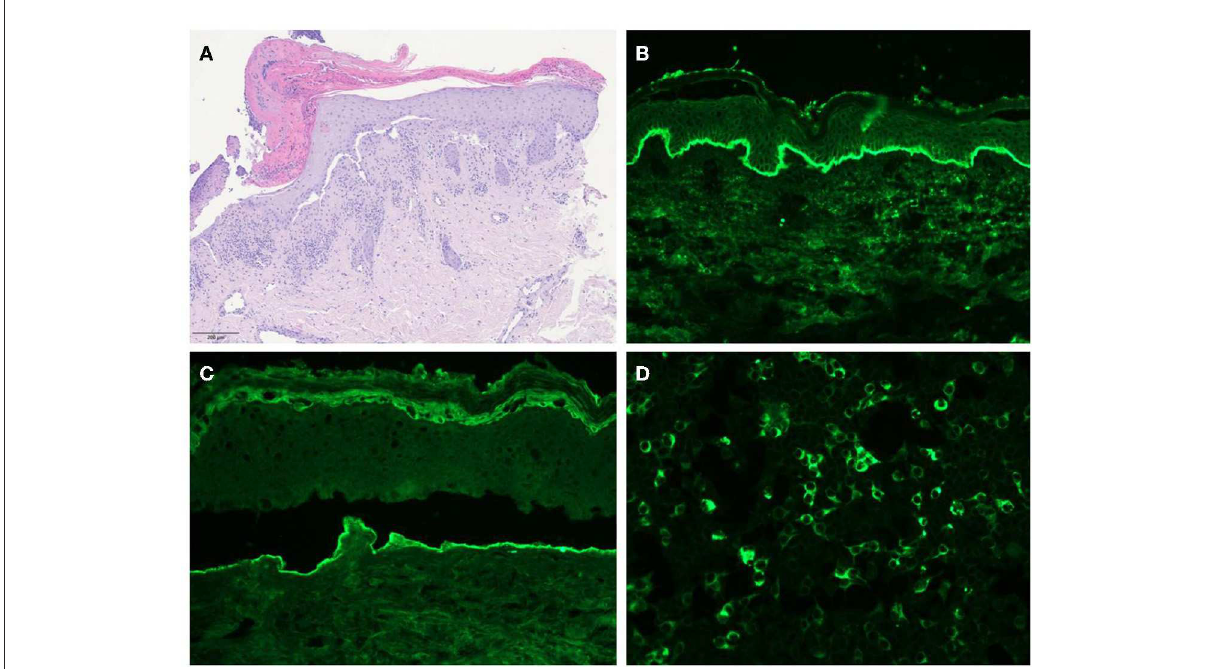
FIGURE2 (A) Histology showing subepidermal blisters and lymphocytic infiltrates with rare eosinophils in the superficial dermis. (B) Direct immunofluorescence revealing IgG deposits along the dermal-epithelial junction. (C) Salt-split skin indirect immunofluorescence showing IgG deposits along the floor of the blister. (D) Indirect immunofluorescence test using recombinant laminin 332 expressed in human HEK293 cells revealing the presence of anti-laminin 332 antibodies in the patient’s serum.